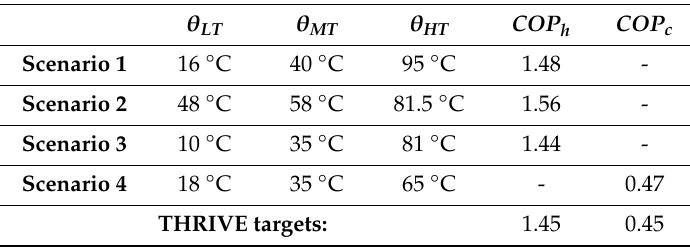
Table 4. Summary of the temperature triplets for the identified scenarios and the estimated COP for heating and cooling applications, respectively.